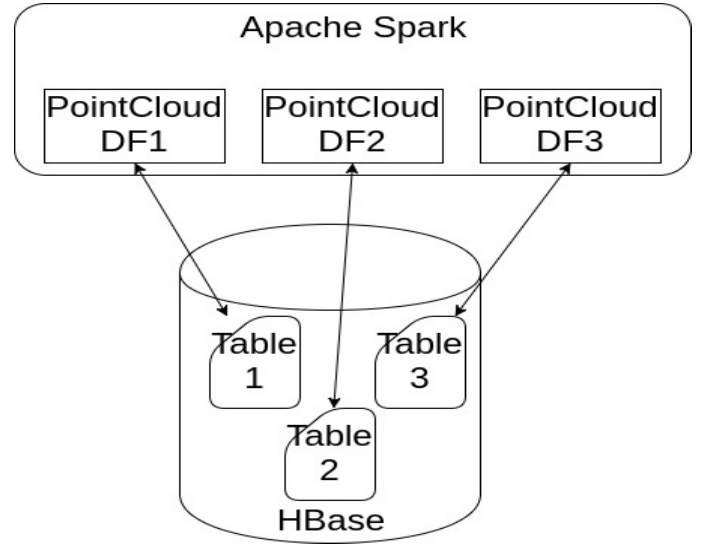
Figure 3. Physical data model.